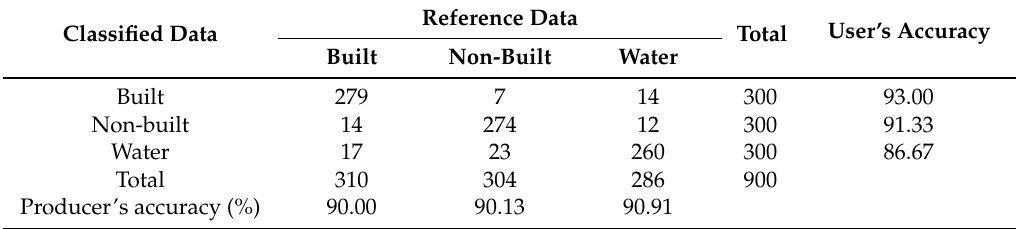
Table A2. Error matrix for the classified 2001 land use/cover